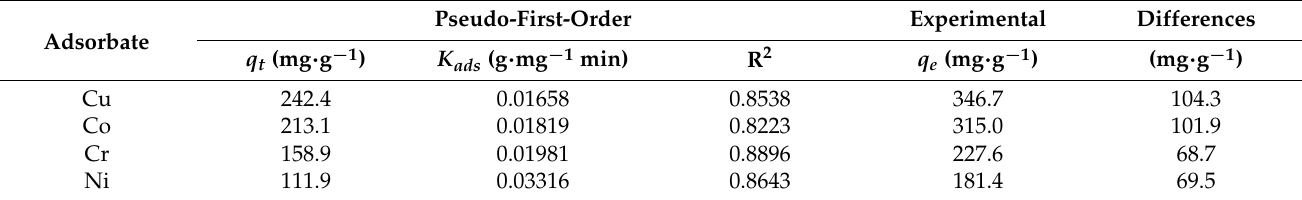
Equation (3) was used to find out the kinetic behavior of pseudo-first-order rate of